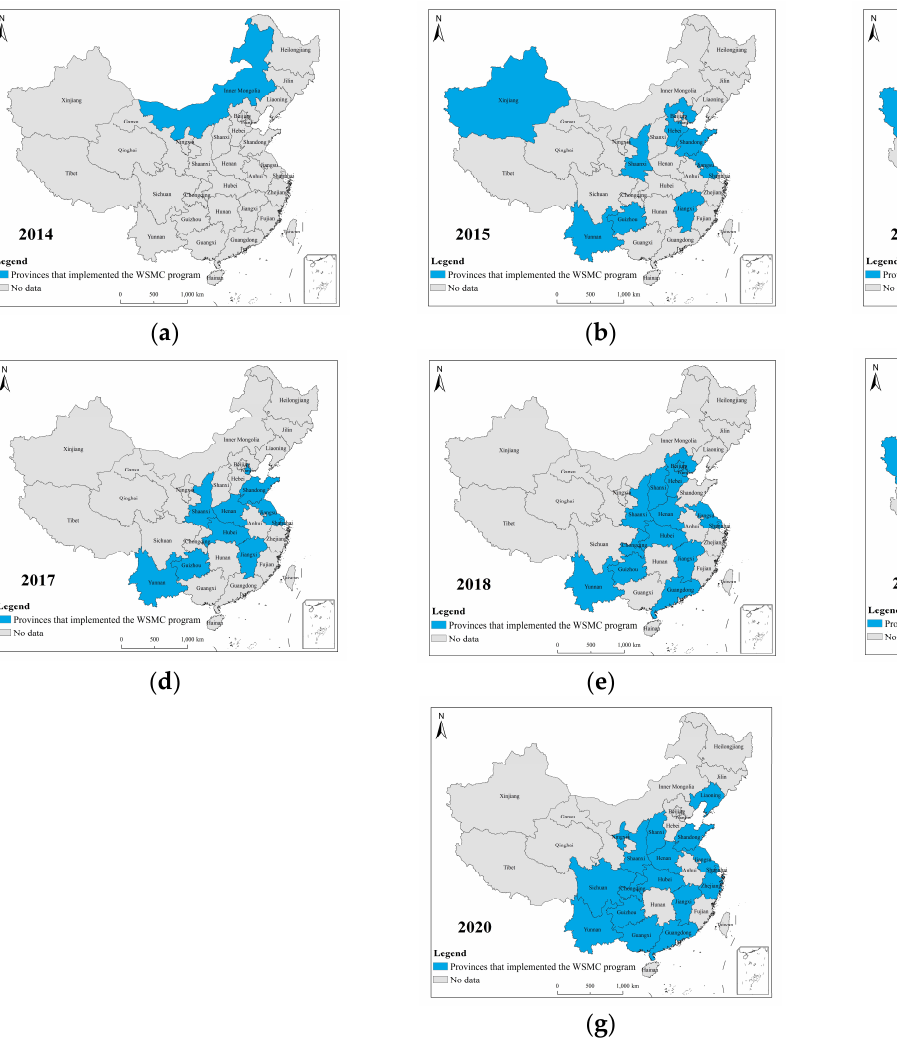
Figure 1. Provinces that implemented the WSMC program by year ( a – g ).